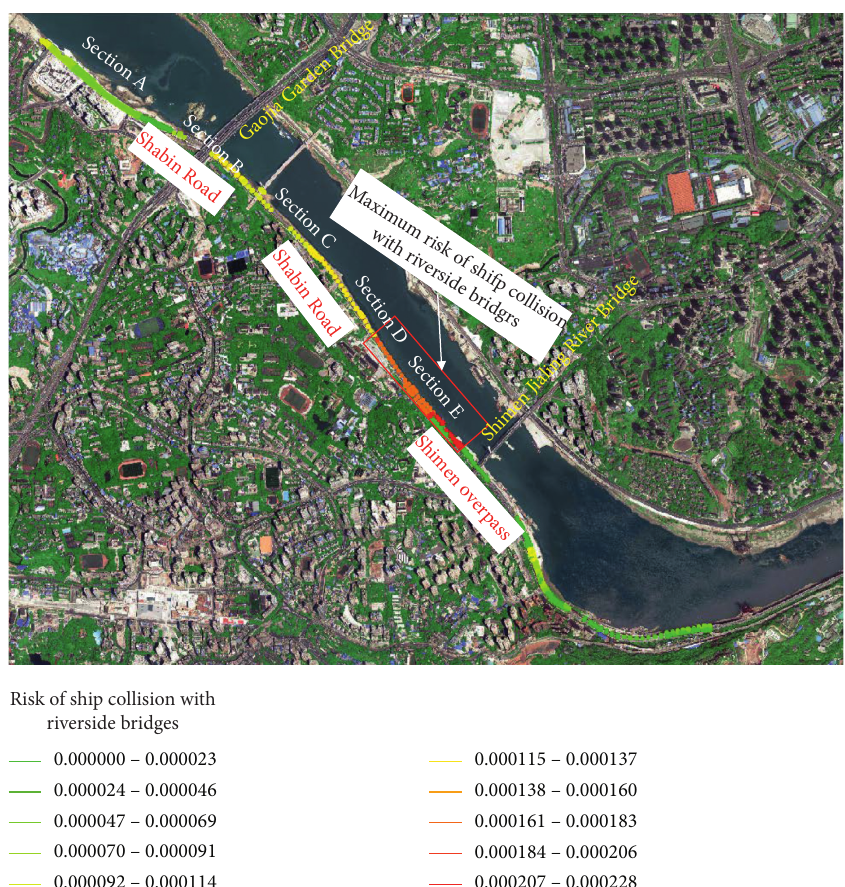
Figure 16: Resultant risk map of ship collision with riverside bridge piers of Shabin Road.